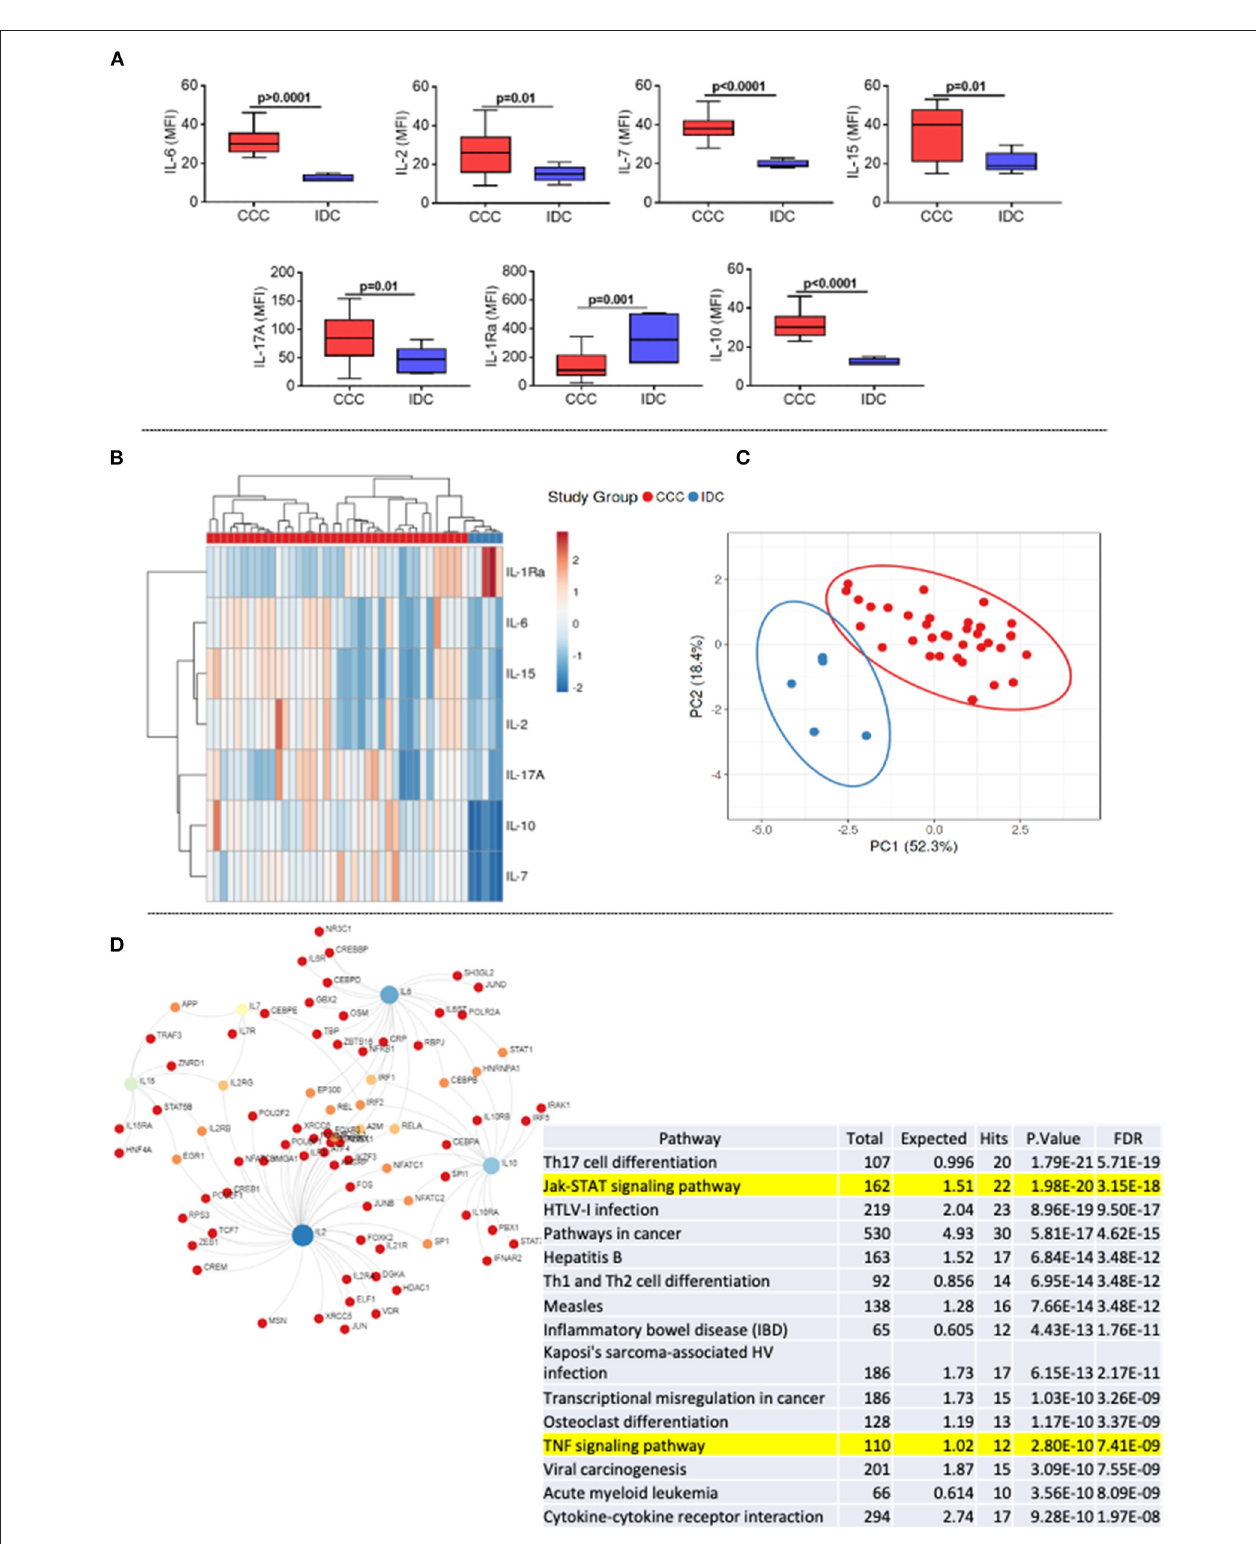
FIGURE 1 | Comparative analysis of plasma cytokines levels between the study groups. (A) Comparative analysis of plasma cytokine levels between patients with Chronic Chagas cardiomyopathy (CCC, n = 38) and Idiopathic cardiomyopathy (IDC, n = 5). Plasma soluble cytokine levels were measured using the Bio-Plex ProTM Human Cytokine Standard 27-plex Kit, and results are expressed in MFI, as described in Materials and Methods. Graphs are expressed as boxplots, with the